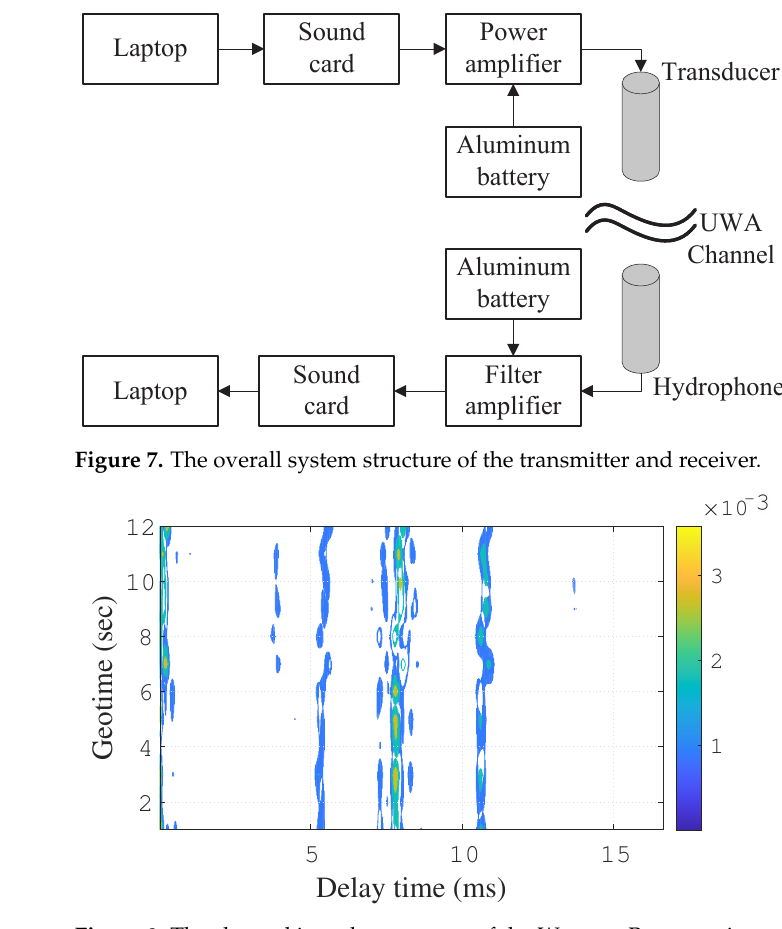
Figure 8. The channel impulse response of the Wuyuan Bay experiment.